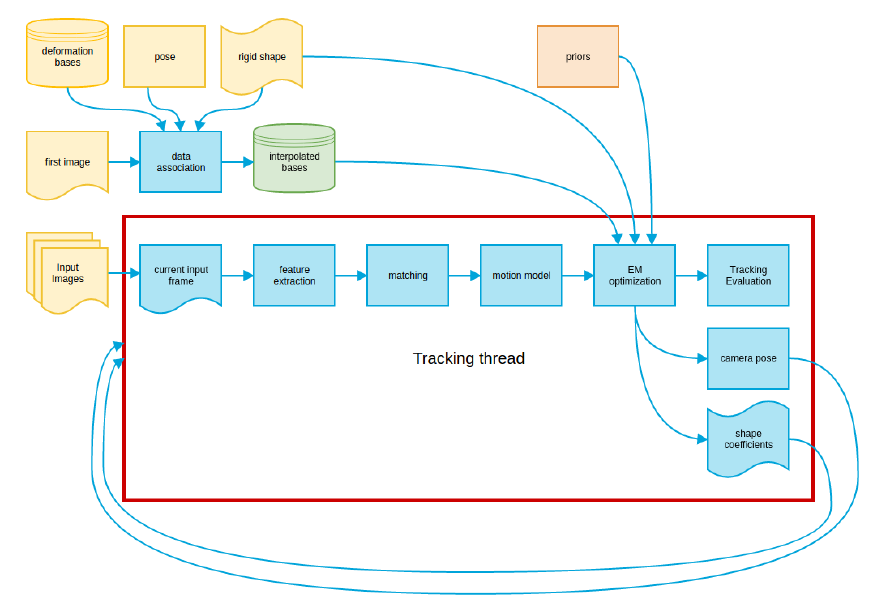
Figure 1. Tracking thread flowchart. The main modules of our tracking thread are included inside the red box. The yellow modules represent inputs; the orange modules are configurations (priors); the green ones are estimations from the input data; and finally, the blue ones are implemented